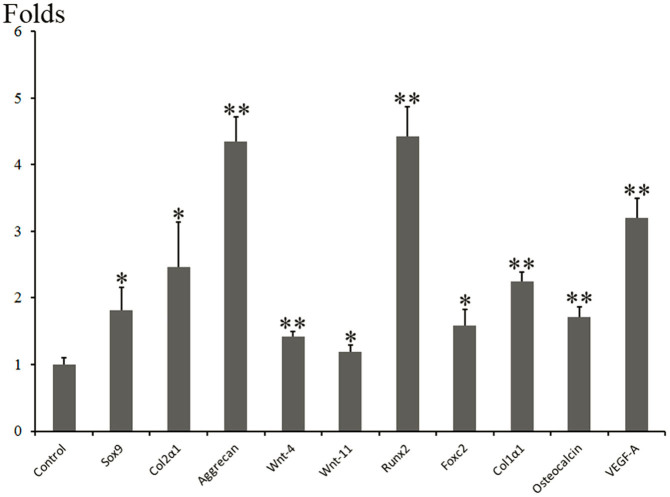
Realtime PCR for analyzing the genes expressions of SC synoviocytes cultured with or without TGF-β3 for 6 days.*P < 0.05, **P < 0.01 with respect to the control. The assay was performed in triplicate under the same experiment conditions.